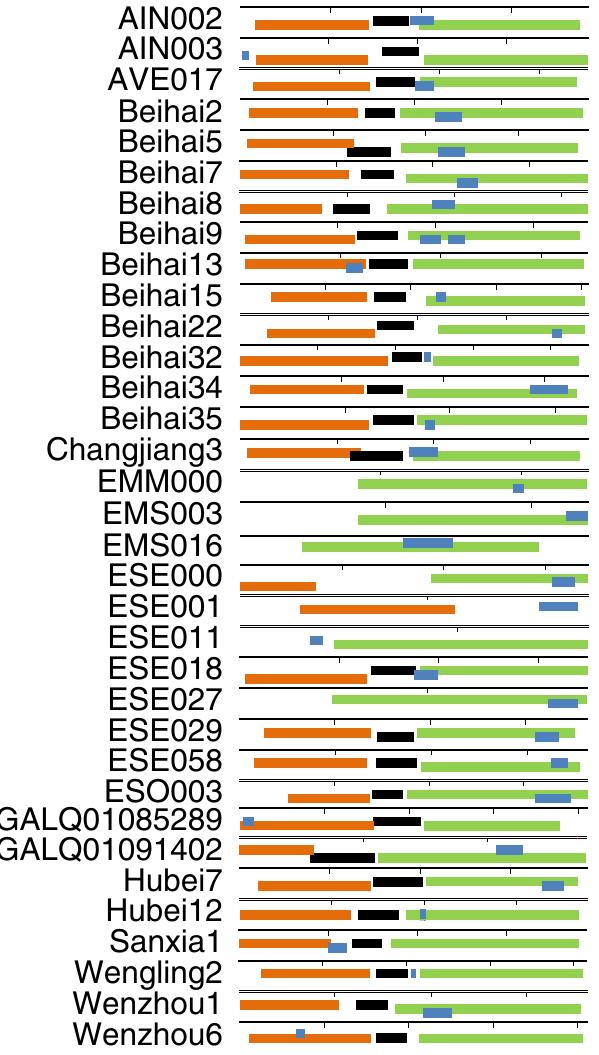
Fig. 1 Genome organization of sgl s discovered in this study. The genome organization of leviviruses with functional sgl s are shown and the three core genes mat , coat , and rep are colored as orange, black, and green, respectively. The length of complete or partial genome is represented by a horizontal black bar above the genes with each perpendicular interval equal to 1 kb. The sgl s (blue) are shown relative to the reading frames of other genes (relative reading frames are represented by different horizontal levels). Beihai9 has two different sgl s in the genome and both are embedded within the rep